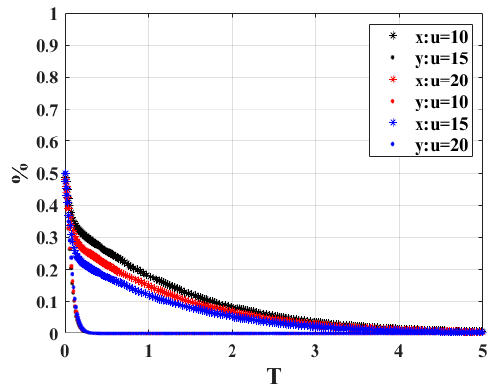
Figure 5. Sensitivity analysis of “ u ”.